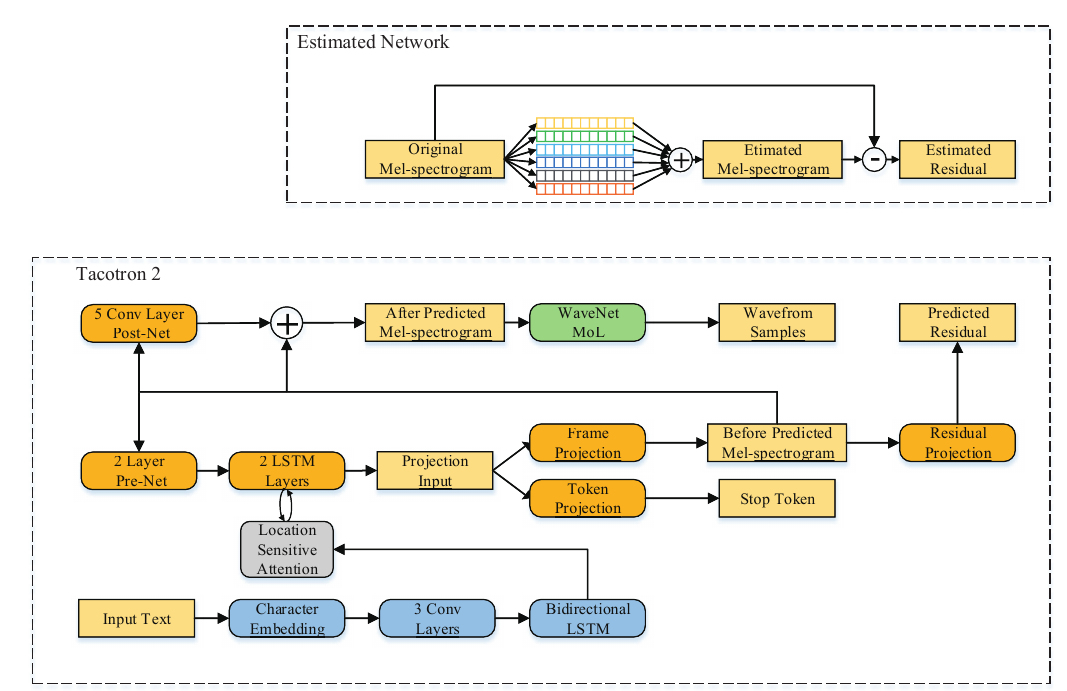
Figure 3. The structure of